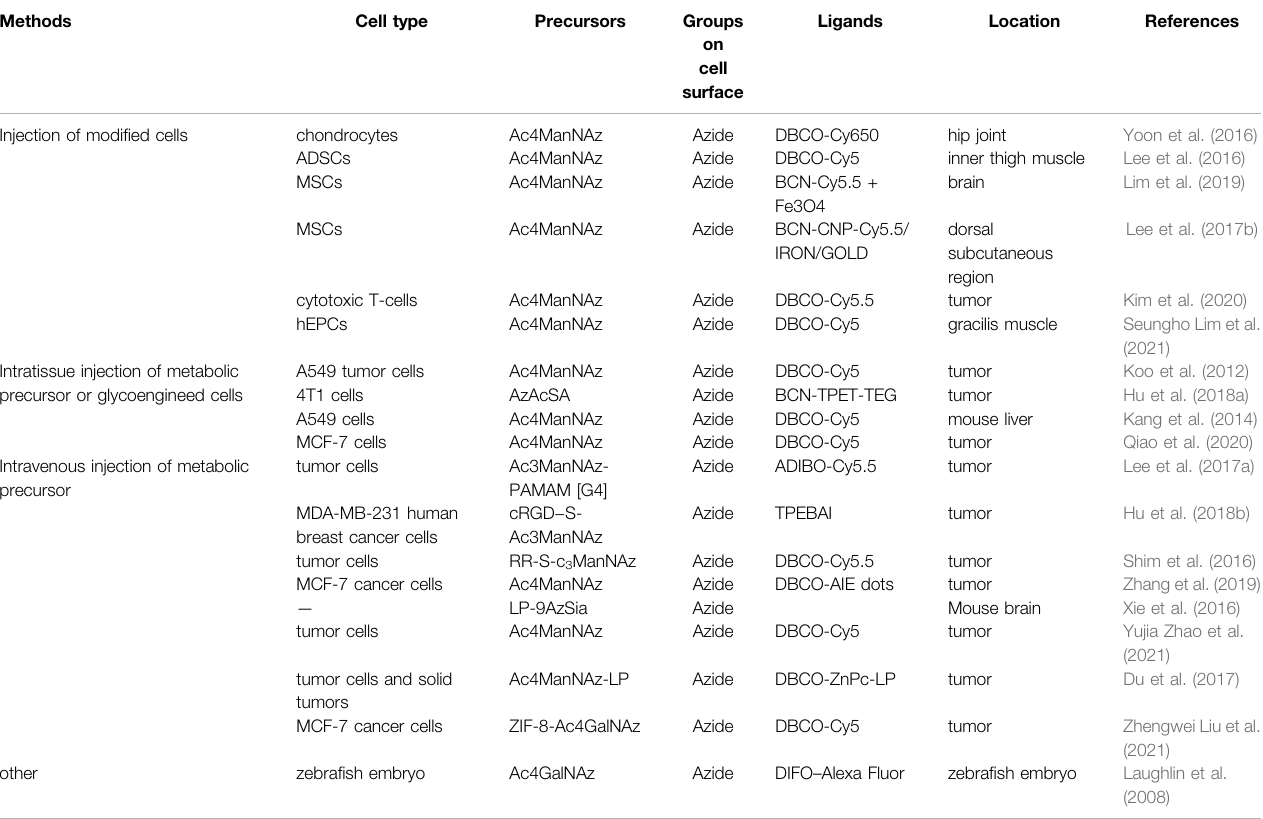
TABLE 2 | Applications of MGE for cellular imaging and tracking.